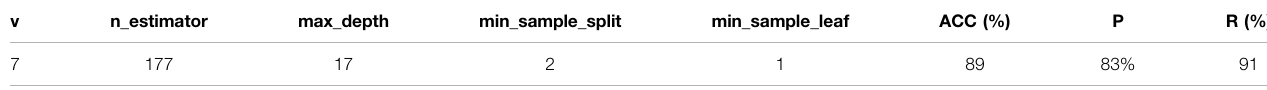
TABLE 2 | Optimal parameters and overall Performance of Random Forest Prediction Model.